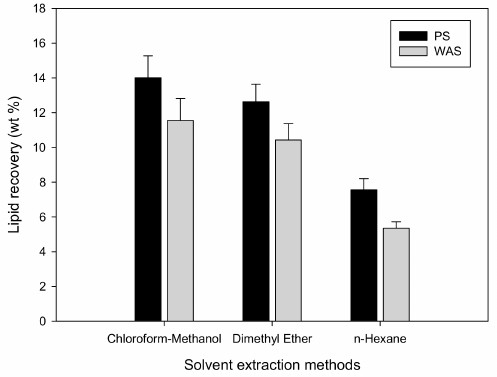
Figure 3. Lipid recovery e ffi ciency from sludges though di ff erential solvent